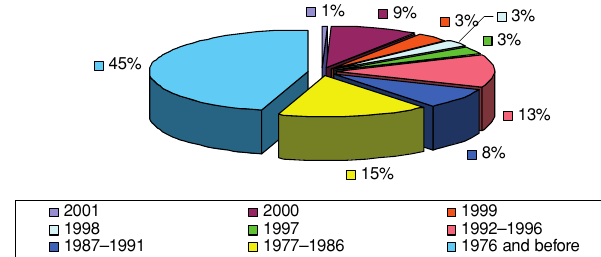
Figure4: Times of the establishment of apple orchards in the Northern Great Plain